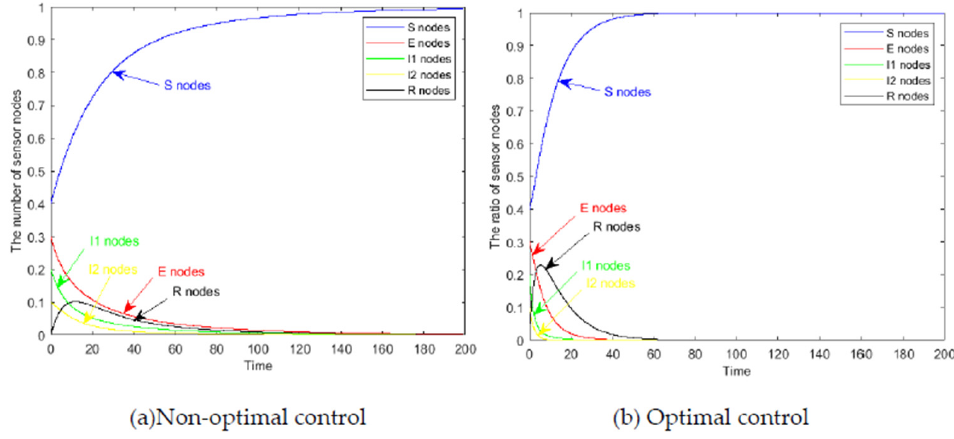
Figure 5. Evolution of sensor nodes under non-optimal control and optimal control.